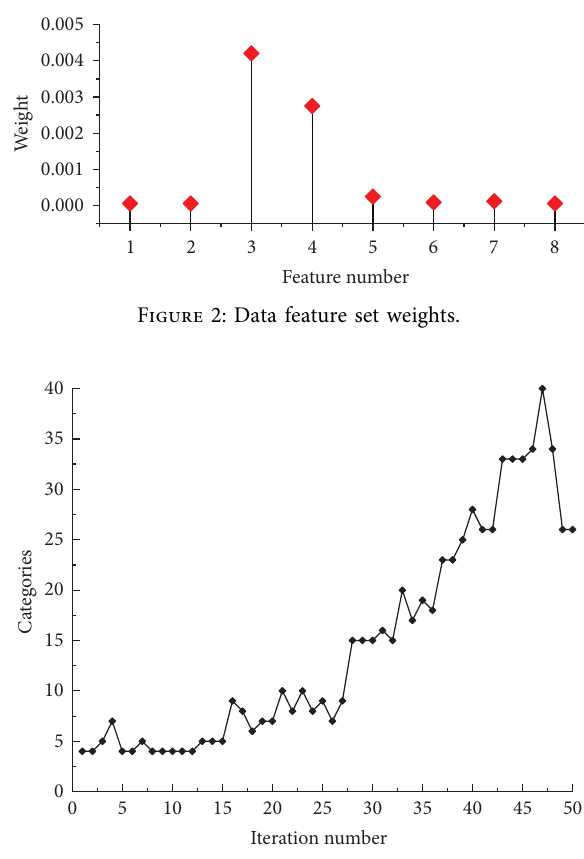
Figure 3: The plot of clustering centers with iterations.